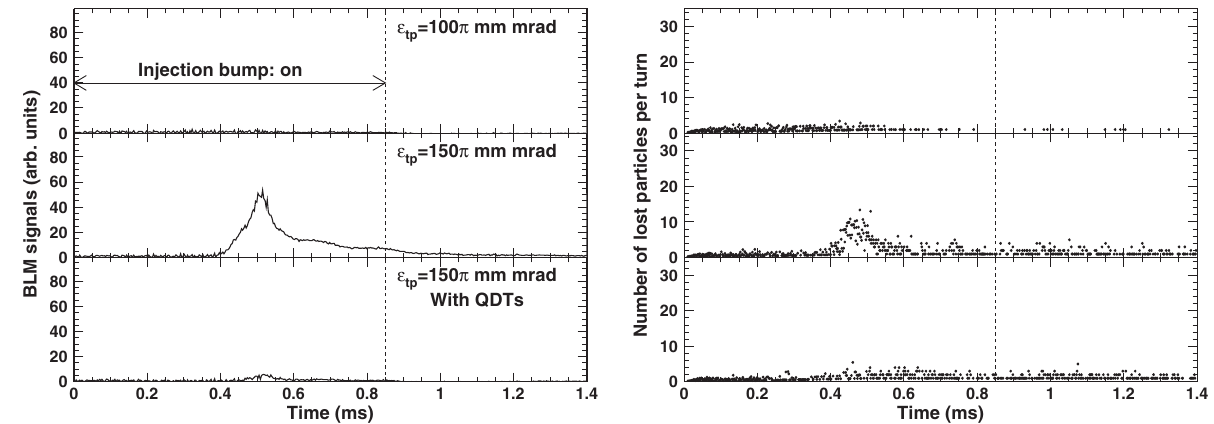
FIG. 31. (Left) Scintillation-type BLM signals over the first 1.4 ms measured at the collimator section with the beam intensity of 850 kW; (top) ϵ tp ¼ 100 π mm mrad, (middle) ϵ tp ¼ 150 π mm mrad, and (bottom) ϵ tp ¼ 150 π mm mrad with QDTs. (Right) Corresponding numerical simulation results.